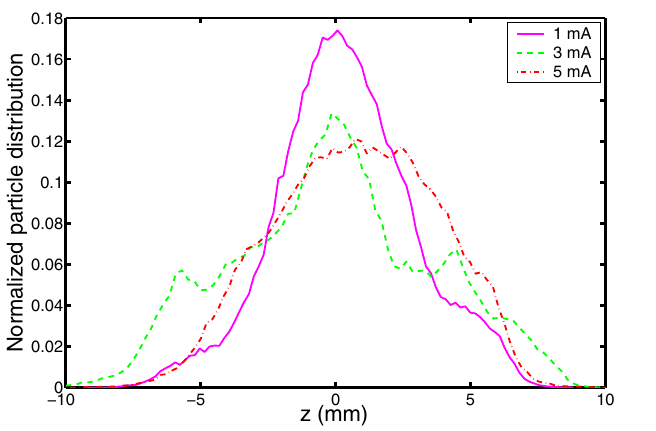
FIG. 13. (Color) Energy spread as a function of current up to 25 mA, under the effect of all the wakefields.